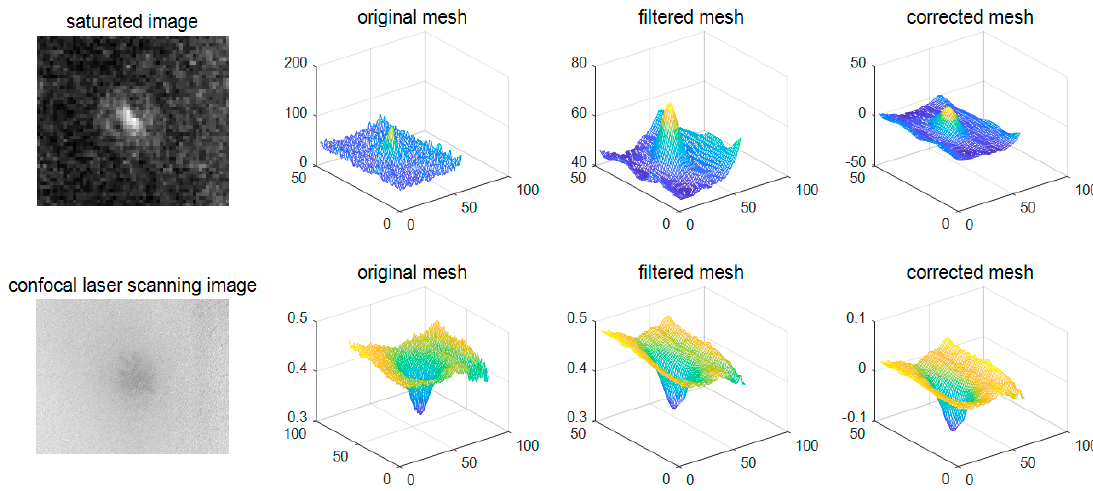
Figure 6. Preprocessing example. The first and second rows show the preprocessing of the saturated image and the confocal microscopy image, respectively, from left to right.